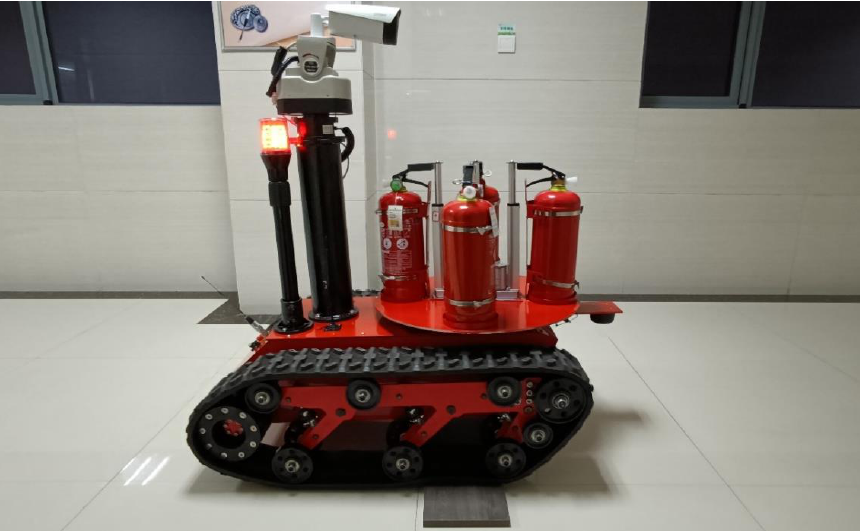
Figure 5. Indoor autonomous inspection firefighting robot.